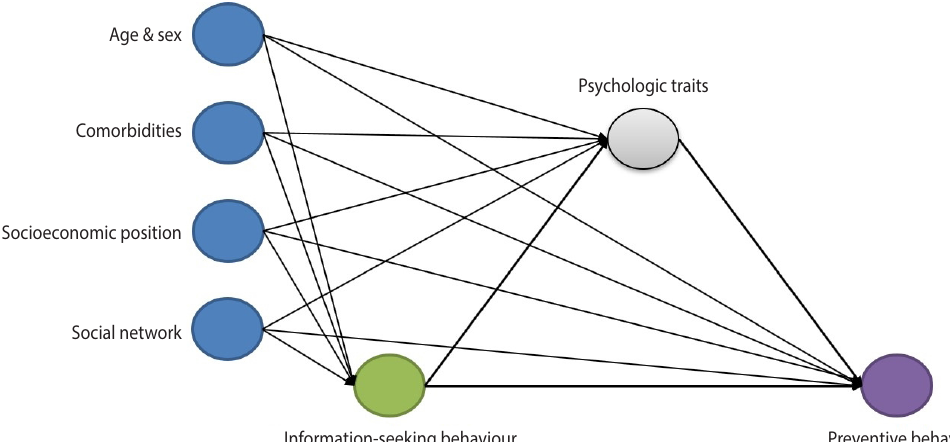
Figure 1. Directed acyclic graph depicting associations among information-seeking behaviours, psychologic symptoms, and preventive